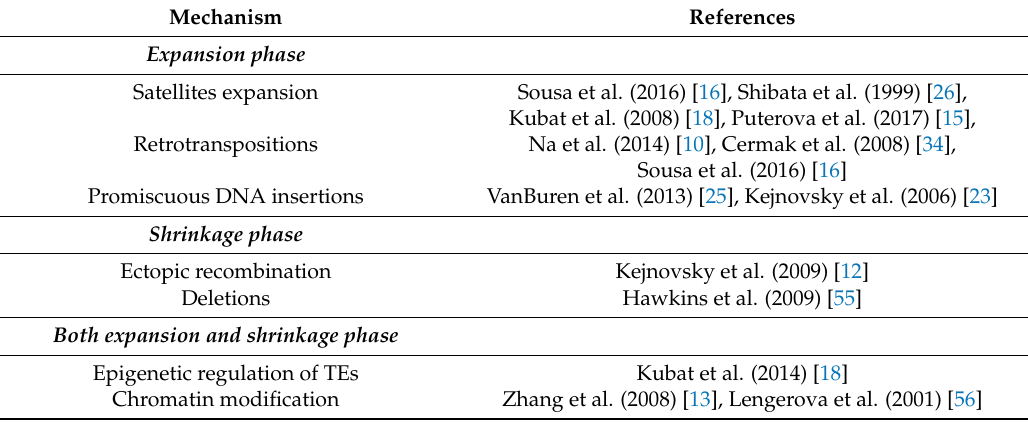
Summary of processes forming sex chromosome structure in the expansion and shrinkage